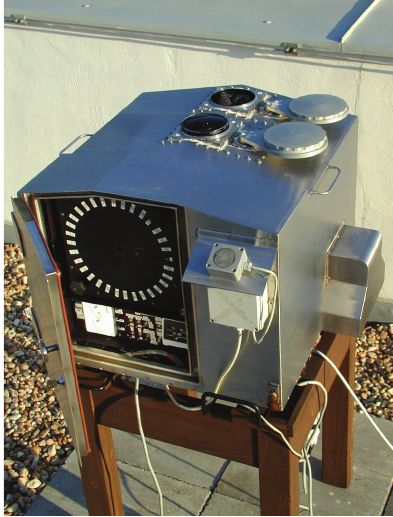
Figure 6: The automated EN sky patrol photographic camera operated by the Ondrejov Observatory, Department of Interstellar Matter.